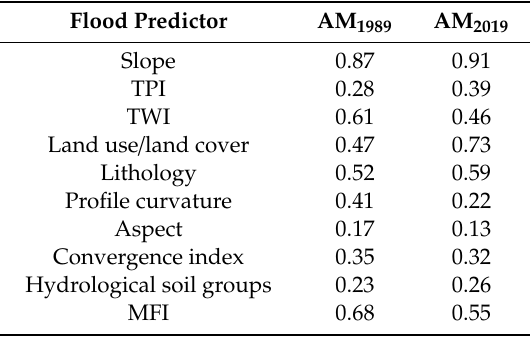
Table 3. Predictive ability of flash-flood